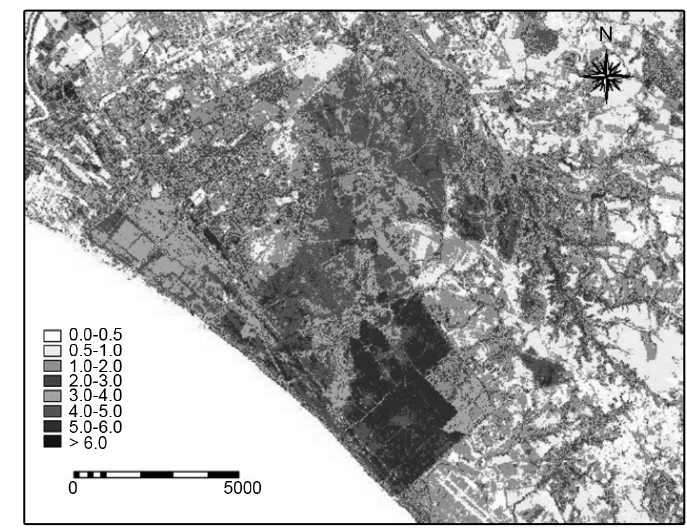
Fig. 4. Plant Area Index map (Landsat 5 TM image of 21 July